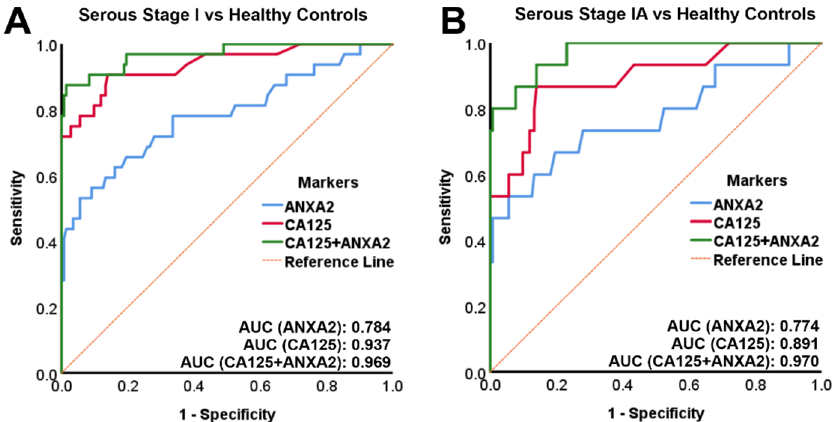
Figure 2. ROC curves for stage I OC versus healthy controls. ( A ) Plasma annexin A2 or CA125 alone and combined plasma annexin A2 + CA125 for stage I OC ( n = 32) versus healthy controls ( n = 143). ( B ) Plasma annexin A2 or CA125 alone and combined plasma annexin A2 + CA125 for stage IA OC ( n = 15) versus healthy controls ( n = 143). Table 1. Sensitivity (%) of ANXA2, CA125 and ANXA2 + CA125 at 100%, 99.6% and 98% specificities, specificities (%) at fixed sensitivity (75%) and AUC from the ROC curve for stage I-IV OC versus healthy controls using the logistic regression model.